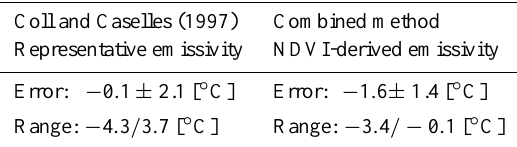
Table 3. Comparison of results obtained with the method of Coll et al. (1994) and using the combined method. Rms LST error, stan- dard deviation, and error range are given Coll and Caselles